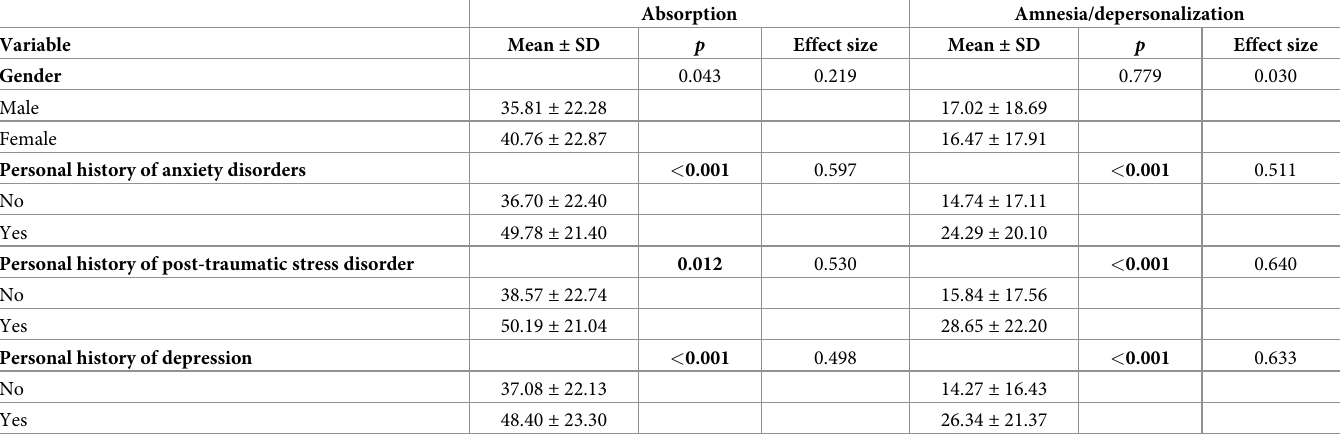
Table 4. Correlation between the dissociative experiences score and other categorical